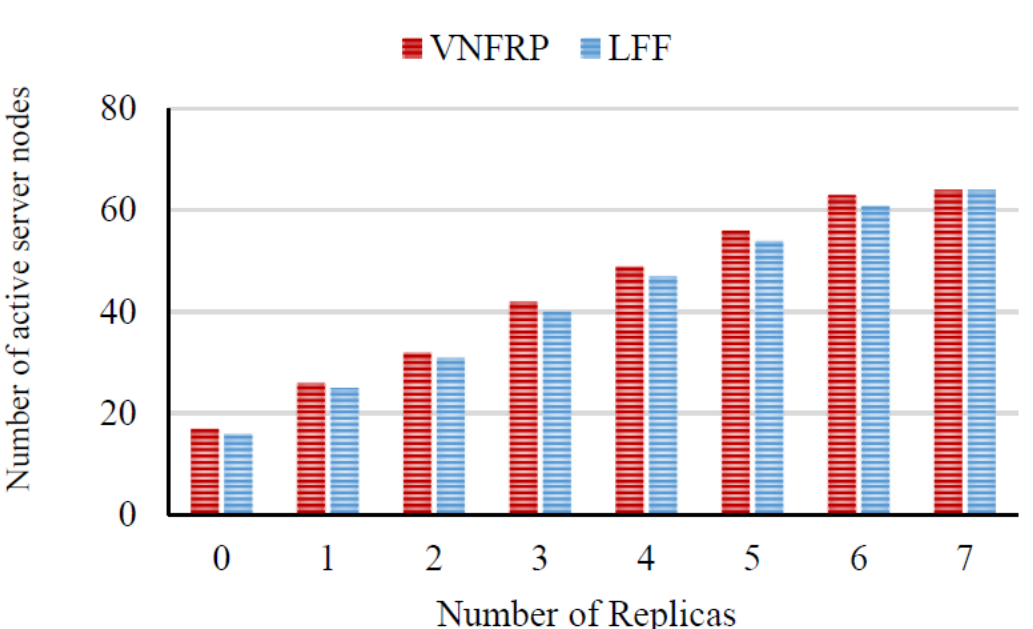
Figure 8. Number of active server nodes when adopting the VNFRP algorithm and the corresponding values when adopting the LFF strategy.